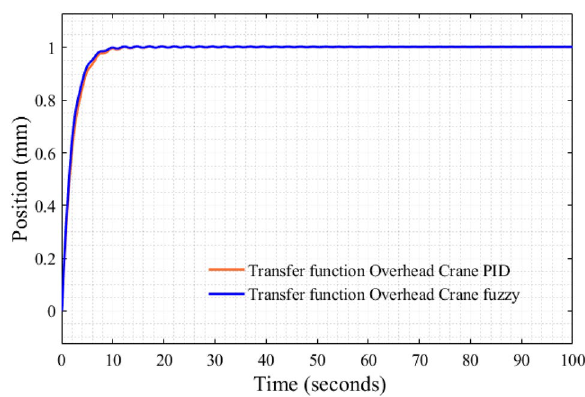
Fig. 14 Graph of both conventional PID and FLC Results for com-